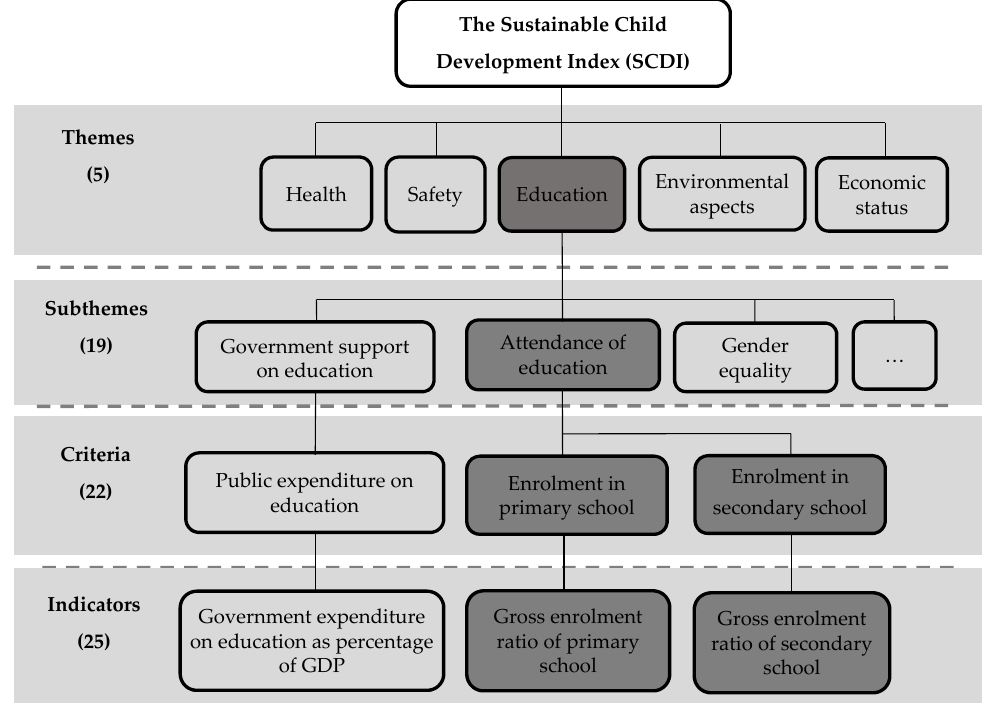
Figure 1. The SCDI framework (exemplary criteria and indicators are presented for the subtheme attendance of education belonging to the theme education and highlighted in dark grey), adapted from Chang et al. [5–7].